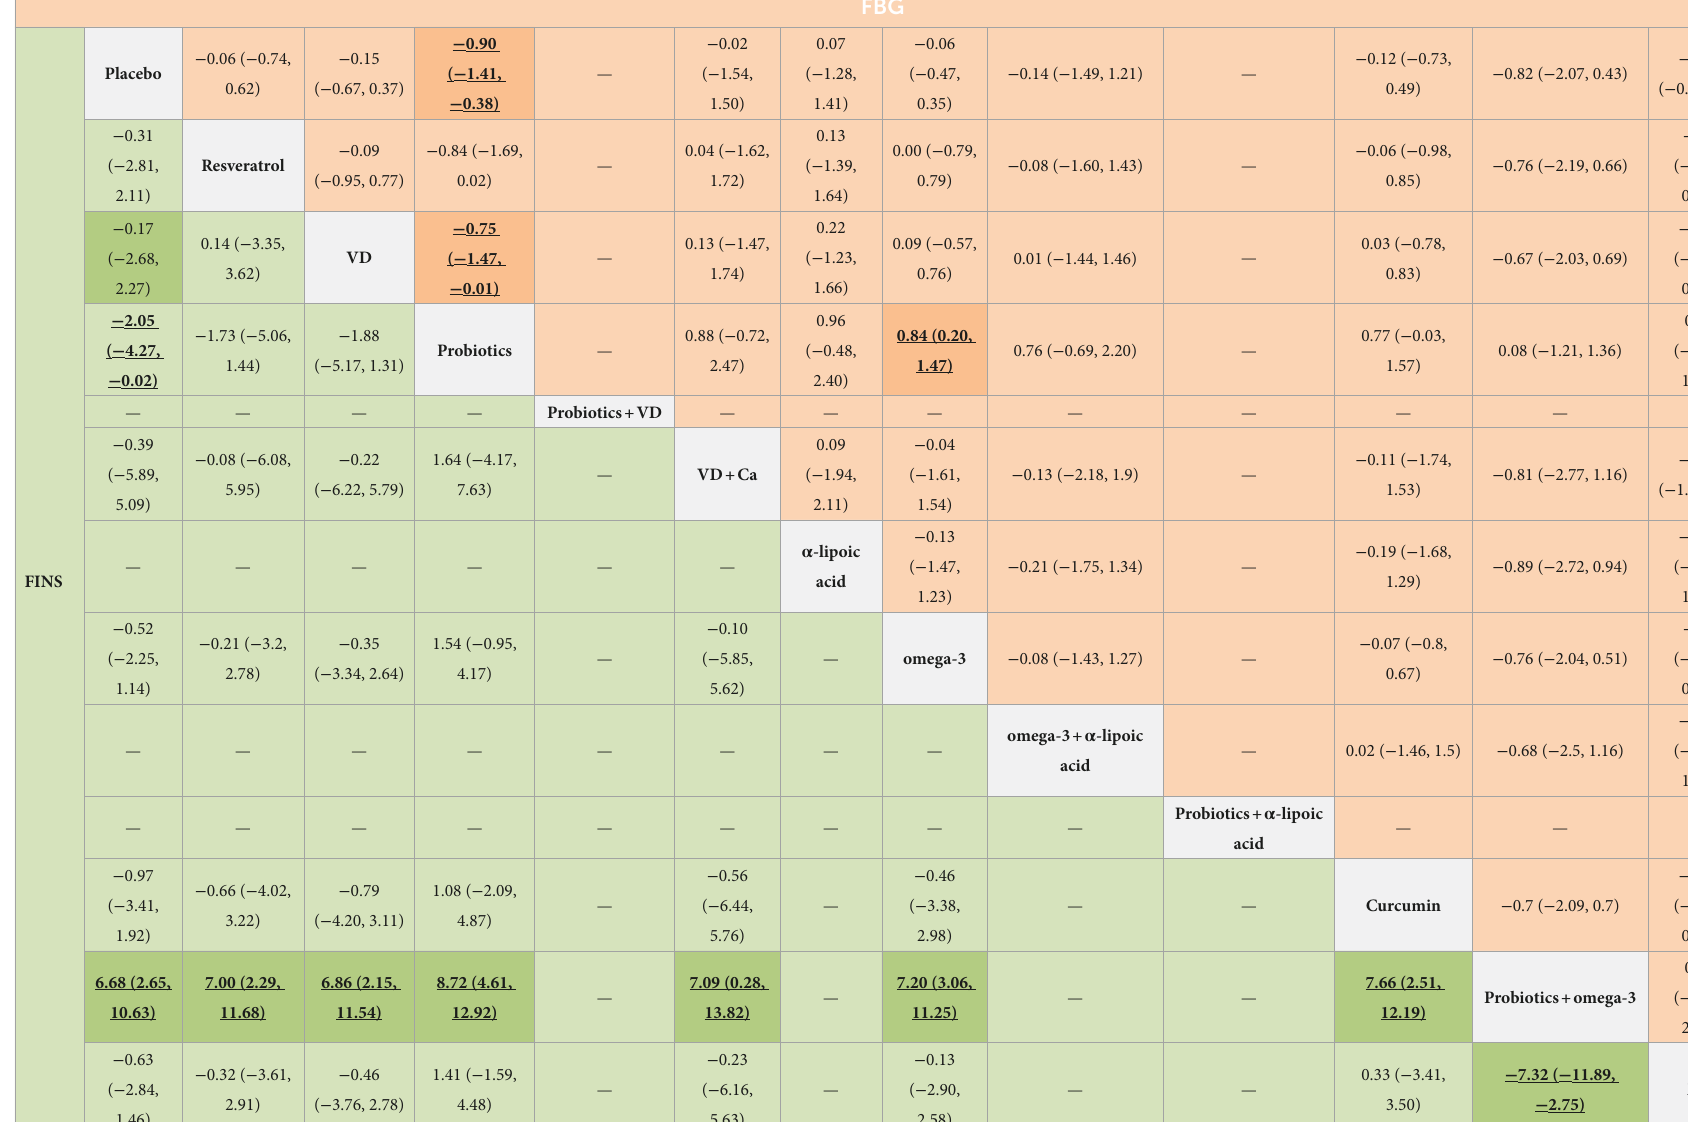
TABLE 3 Results of the network meta-analysis of FINS (lower-left quadrant) and FBG (upper-right quadrant).